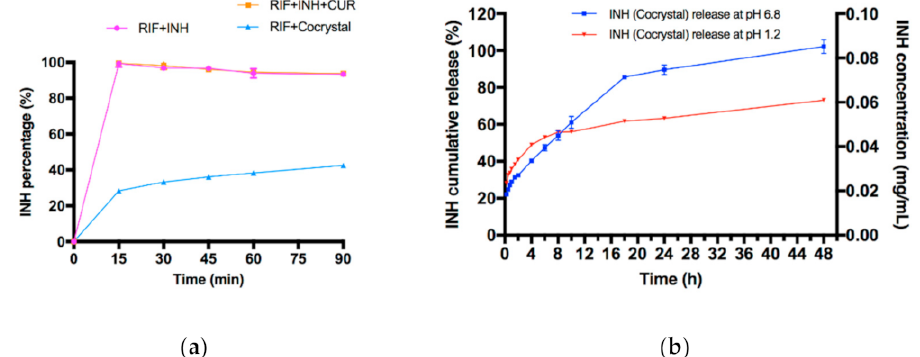
Figure 7. ( a ) Dissolution profiles of INH from different samples in pH 1.2 buffer solution ( n = 3); ( b ) dissolution profile of INH from 2:1 INH-CUR cocrystal in the presence of RIF in pH 1.2 and pH 6.8 buffer solutions ( n = 3) [90] (with permission from [90]; Copyright 2020 American Chemical